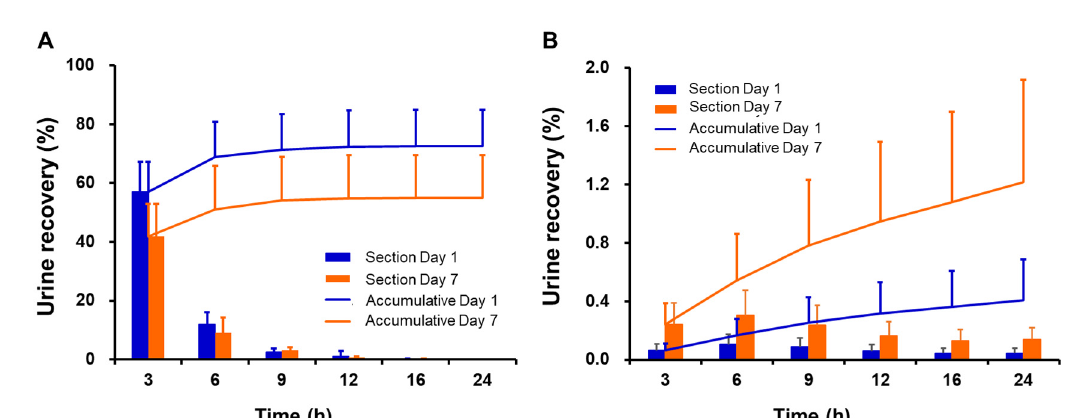
Figure 2. Mean urine excretion rate–time curves of CMS ( A ) and colistin ( B ) in healthy subjects after multiple doses of 2.5 mg/kg CBA CMS intravenous infusions. (The bar graph shows the interval segmented urine excretion rate, and the line indicates the cumulative urine excretion rate. The data are presented as the means and standard deviations from 12 subjects.)